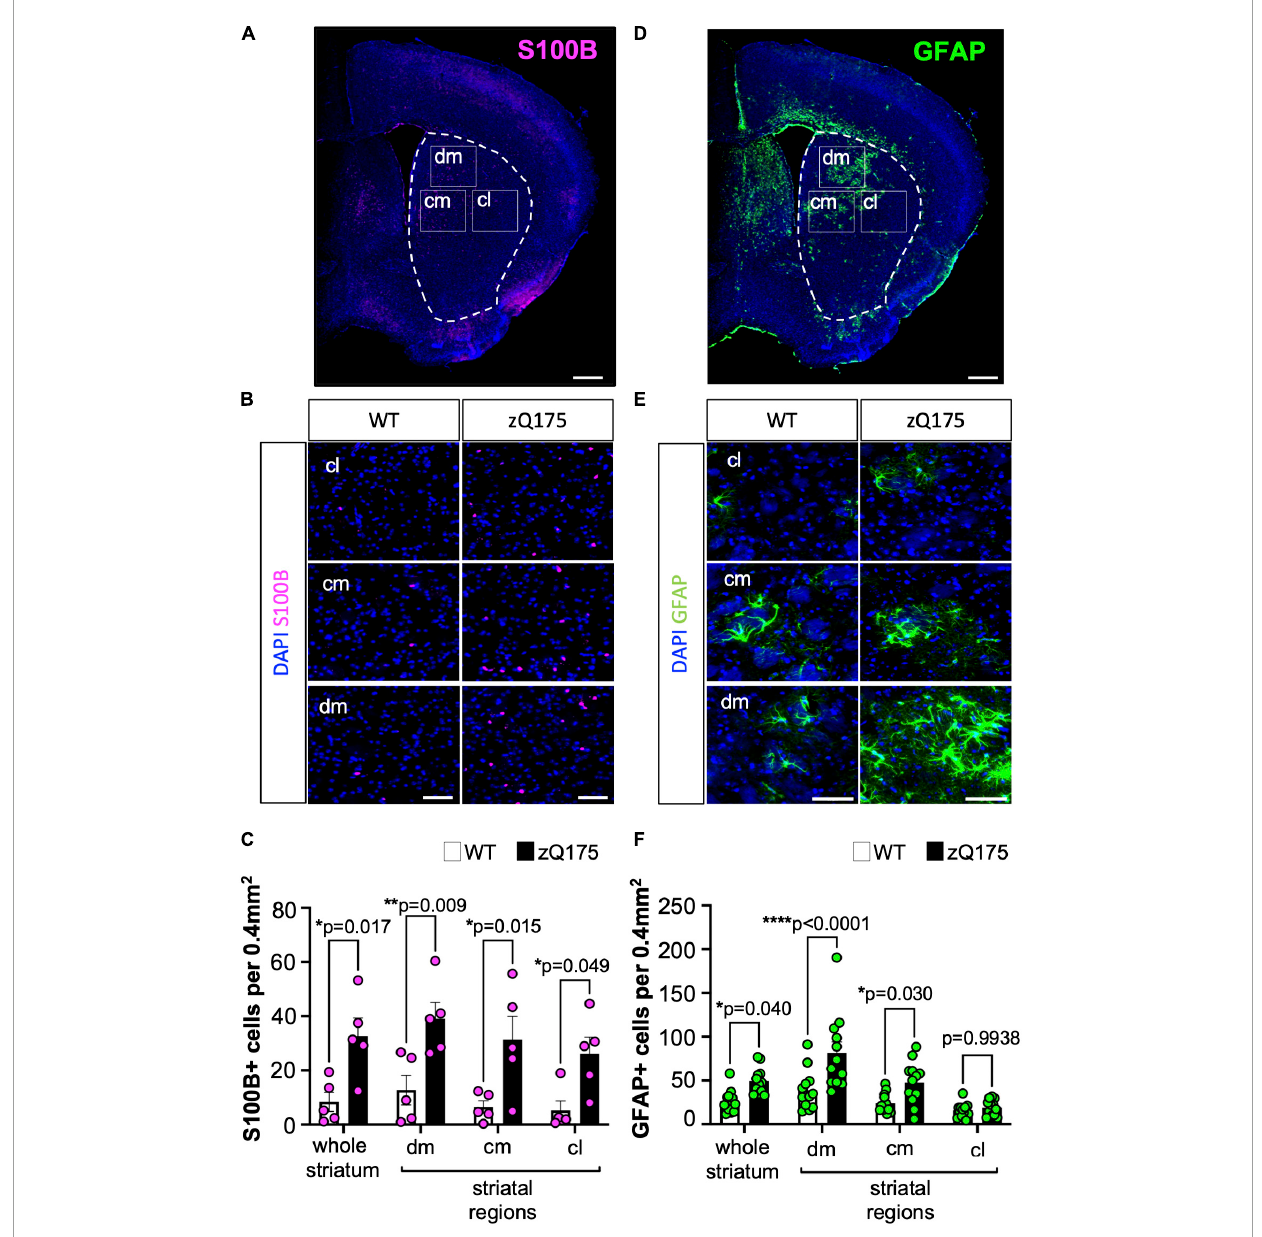
FIGURE1 Number of GFAP + and S100B + astrocytes is differentially increased throughout the striatum of zQ175 mice. (A) Representative coronal section of the immunostaining of S100B and DAPI (stain nuclei) of the zQ175 mouse brain. The dotted line represents the striatum and rectangles represent dorsomedial (dm), centromedial (cm), and centrolateral (cl) regions. Scale bar, 500 µ m. (B) Representative S100B immunostaining in dm, cm, and cl regions of the striatum in 12-month-old WT and zQ175 mice. DAPI stains nuclei. Scale bar, 50 µ m. (C) S100B + astrocytes number per 0.4 mm 2 in whole striatum and in striatal regions ( n = 5 mice/genotype) analyzed from images in (B) . (D) Representative coronal section of the immunostaining of GFAP and DAPI (stain nuclei) of the zQ175 mouse brain. Scale bar, 500 µ m. (E) Representative GFAP immunostaining in dm, cm, and cl regions of the striatum in 12-month-old WT and zQ175 mice. Scale bar, 50 µ m. (F) GFAP + astrocyte number per 0.4 mm 2 in whole striatum and in striatal regions ( n = 12 mice/genotype). Number of cells in the whole striatum is calculated as the average of all three regions. Error bars denote mean ± SEM. Two-way ANOVA with Sidak’s multiple comparisons [ (D) Interaction: F = 0.08170, df = 3; striatal region: F = 1.157, df = 3; genotype: F = 37.04, df = 1. (F) Interaction: F = 3.391, df = 3; striatal region: F = 16.10, df = 3; genotype: F = 28.04, df = 1]. Only p -values for comparisons between WT and zQ175 are shown. * p < 0.05, ** p < 0.01, **** p < 0.0001.